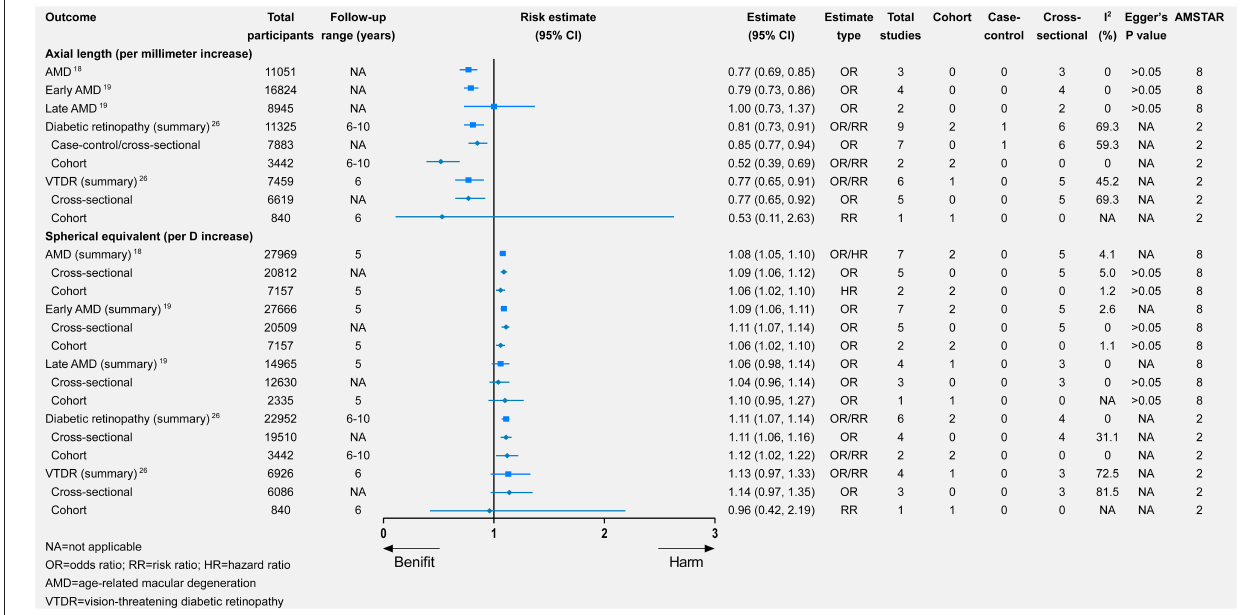
FIGURE 6 | Associations of changes in axial length and spherical equivalent with multiple eye health